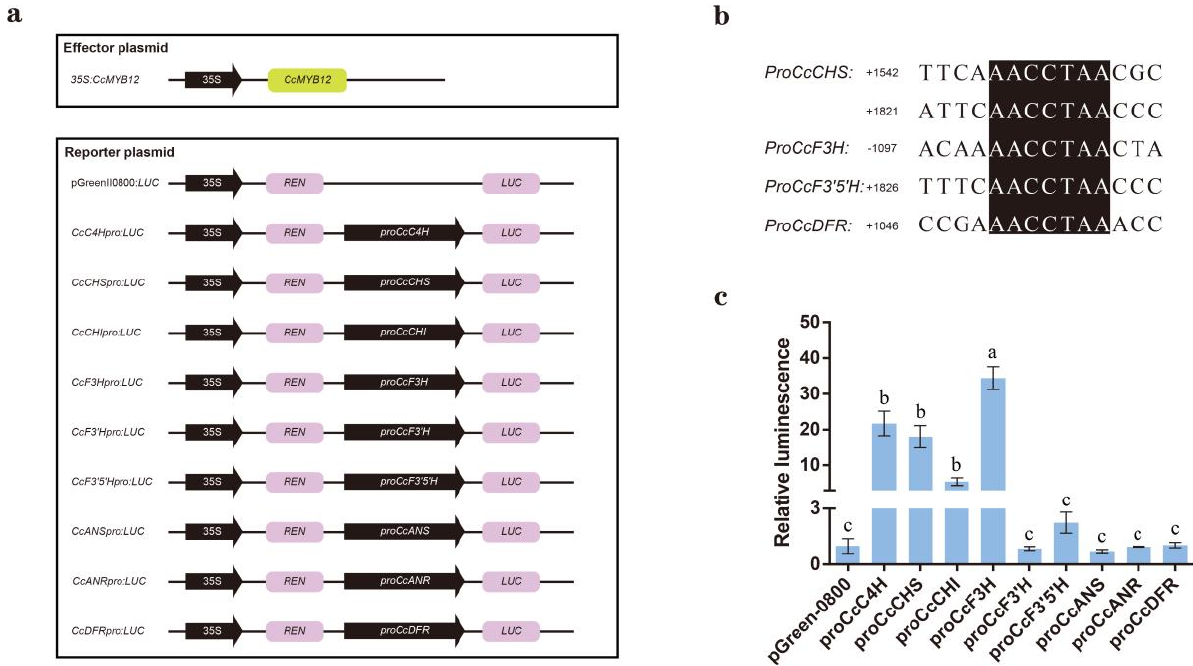
Figure 6. CcMYB12 can directly activate some genes involved in flavonoids synthesis. ( a ) Schematic diagram of construction of effector and promoter for DLRA. ( b ) Binding element analysis of pro- moters of CcC4H , CcCHI , CcF3H , CcF3’H , CcF3’5’H , CcANR , CcANS , and CcDFR based on AtMYB12. ( c ) Transcriptional activation analysis of CcMYB12 on CcC4H , CcCHI , CcF3H , CcF3’H , CcF3’5’H , CcANR , CcANS , and CcDFR . LUC and REN of samples were determined sequentially with a GLO − MAX 20/20 photometer (Promega, USA), and the ratio of LUC and REN was taken as tran- scriptional activity. The data from 3 biological replicates are presented as mean ± SE. Various letters in error bar indicate obvious differences among distinct groups (Duncan test, p < 0.05). 2.7. CcMYB12 Promoted the Expression of a Series of Flavonoid Biosynthesis Genes and